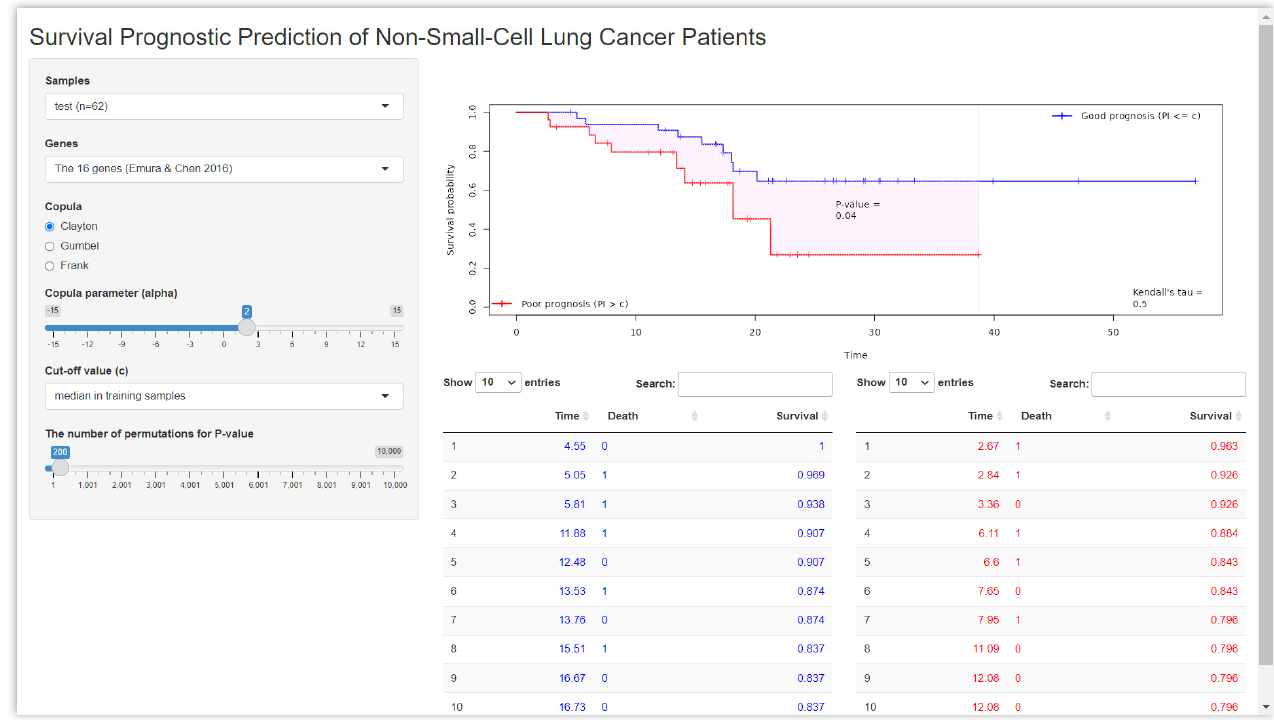
Figure 4. The web application for the sensitivity analysis based on the lung cancer data. The interactive web version is available in https://takeshi.shinyapps.io/lung/ (accessed on 10 January 2023). The main goal of this web application is to visualize how the two prognosis groups are separated by the 16-gene PI for a user-specified choice of φ α ( . ) (copula) and any value of α (copula